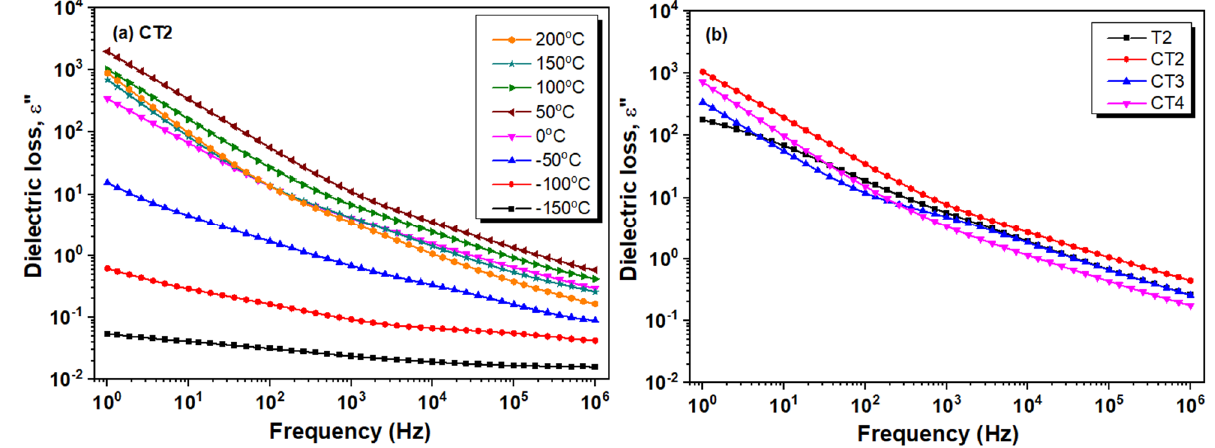
Figure 10. The evolution of dielectric loss as a function of frequency: ( a ) exemplarily for CT2 at various temperatures and ( b ) comparatively for all examined samples at room temperature.